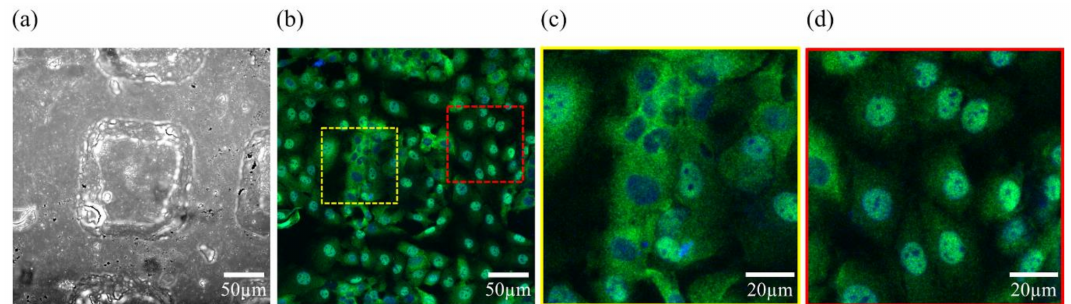
Figure 7. ( a ) Bright field photograph of a squared microwell. ( b ) Regionalized hepatic C9 cells cultured onto PDMS replica, (yellow discontinued square corresponds to ( c ) and the red one corresponds to ( d )). ( c ) In response to spatial confinement, cells upon/atop the microwell present YAP/TAZ (green) in the cytoplasm as shown by the non-colocalization with the nuclei stained with DAPI (blue). ( d ) On the contrary, cells outside the microwell, have YAP/TAZ in the nuclei, as shown by the colocalization with DAPI (full experiment unpublished at the